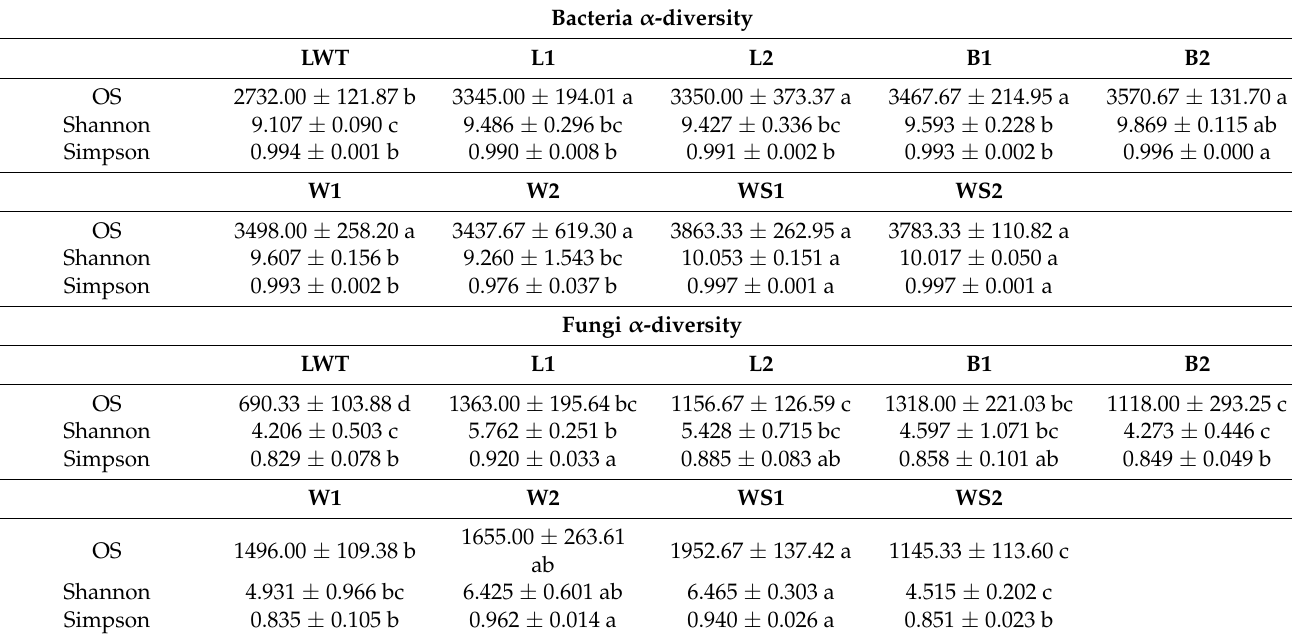
Table 3. Alpha-diversity, including observed-species, Shannon and Simpson indices of the soil bacterial and fungal community in the Phragmites marsh sampling sites.